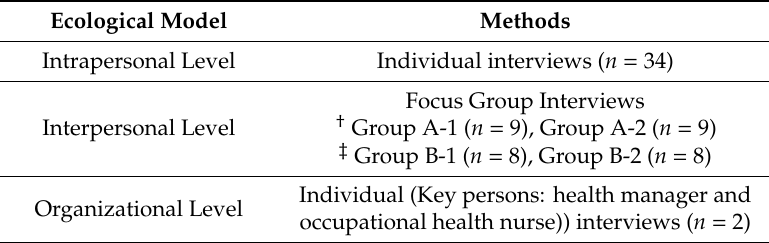
Table 1. Data-collection procedure based on the socioecological